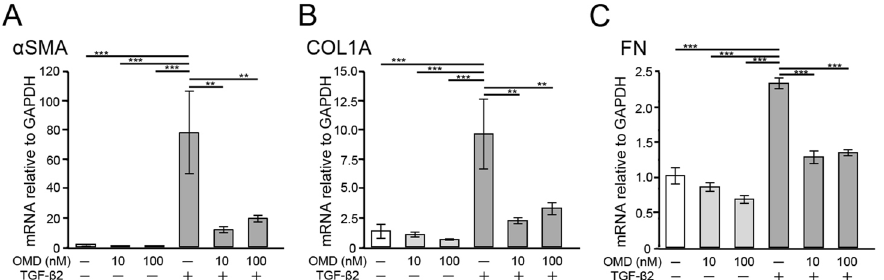
Figure 1. Effects of omidenepag (OMD) on transforming growth factor-β2-(TGF-β2)-induced mRNA expression of alpha smooth muscle actin (αSMA), collagen type I alpha 1 chain (COL1A), and fibronectin (FN) in human trabecular meshwork (HTM) cells. The mRNA expression of αSMA, COL1A, and FN in HTM cells after 24 h was evaluated using quantitative real-time polymerase chain reaction. TGF-β2-induced significant upregulation of αSMA, COL1A, and FN expression and OMD at 10 and 100 nM inhibited all changes significantly. Data are presented as the mean ± standard error (SE), n = 4. * P < 0.05, ** P < 0.01, and *** P < 0.001 relative to the TGF-β2-treated group (Dunnett’s multiple comparisons